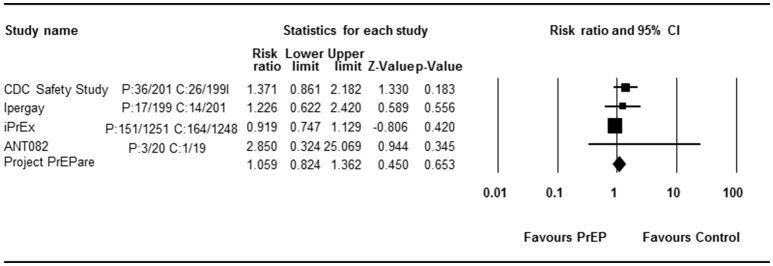
Forest plot for overall analysis of PrEP and grade 3 or 4 AEs (RR).